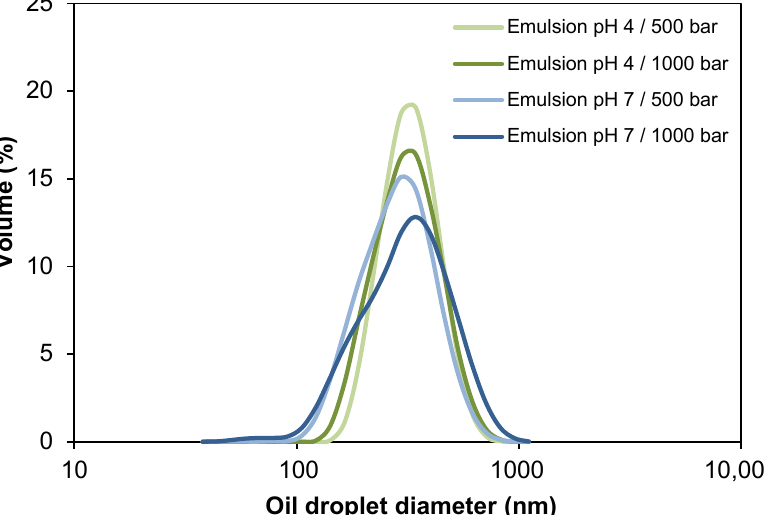
Figure 2. Influence of pH and homogenization pressure on the oil droplet size distribution of O/W